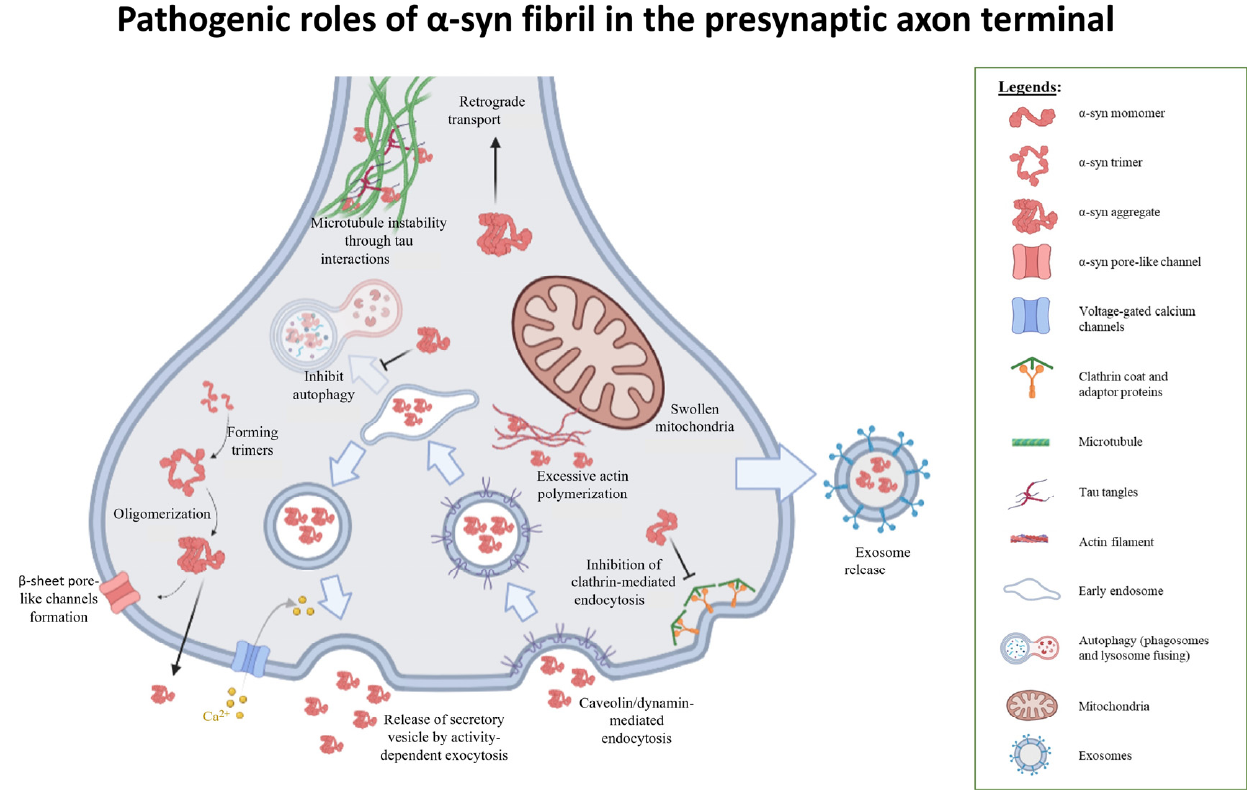
Figure 3. Putative effects of pathogenic α -syn in the presynaptic axon terminal. α -syn monomers forms trimers [27,41], which further oligomerizes to form amyloid fibrils [41], or β -sheet-like pores at the cell membrane [36,37]. Fibrils may interfere with cytoskeletal polymerization and depolymer- ization dynamics [97,98,101], mitochondrial fusion/fission dynamics [101,105,106], impairs clathrin- mediated endocytosis [27], and inhibiting autophagic systems [38,90,91], to cause a pleiotropic range of effects on the presynaptic axon terminal. Furthermore, α -syn fibrils may be released and taken in at the presynaptic axon terminal [110,111,119], suggesting the bidirectional transport of α -syn across neuronal synapses. Figure is created with